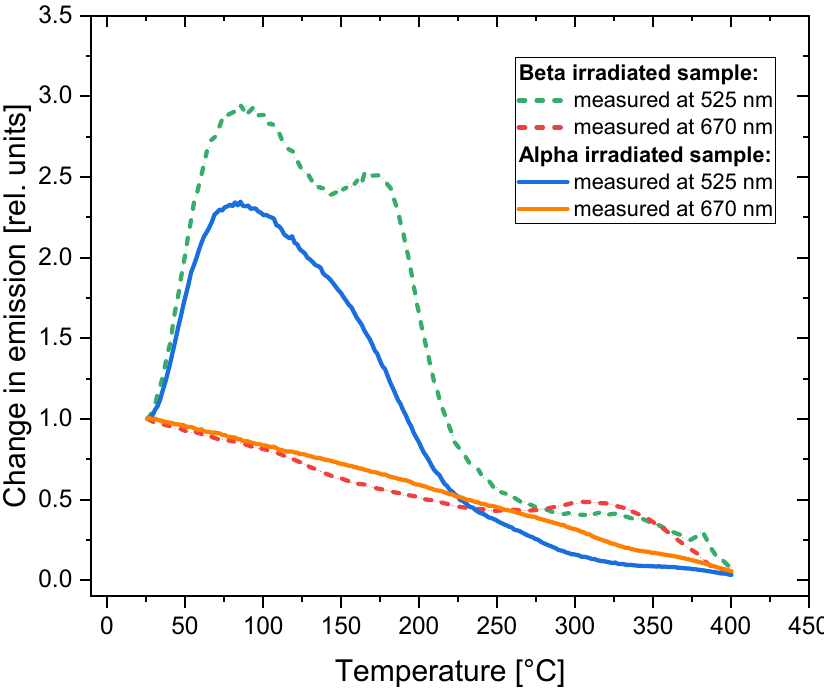
Figure 15. Changes in PL intensity with respect to the values at room temperature measured while heating the sample (the sample submitted to Method 2). Changes were measured for the sample irradiated with 8 kGy of beta radiation from the Sr-90/Y-90 source and for the sample irradiated with alpha particles from the Am-241 source (fluence 10 12 cm − 2 ). All data are normalized to the respective values measured at RT.